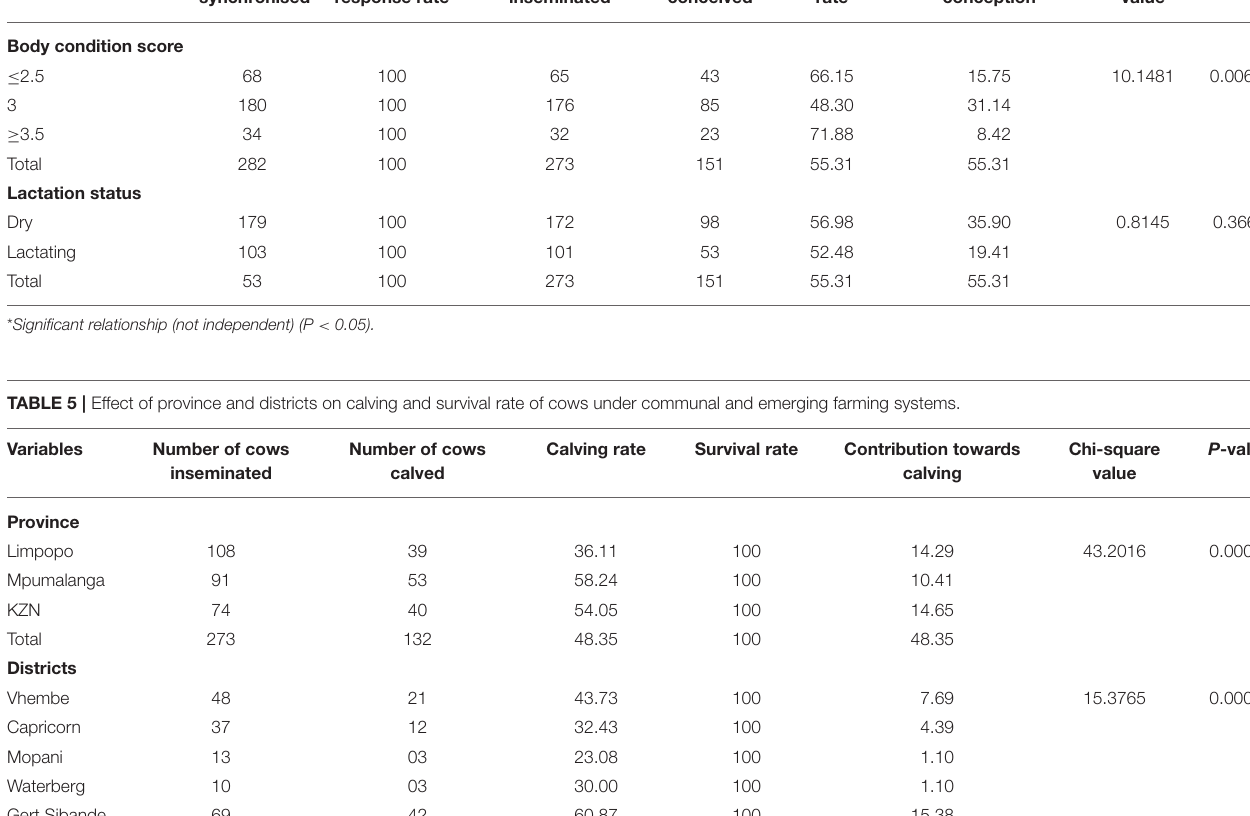
TABLE 4 | Effect of body condition score and lactation status on synchronisation response and conception rate of cows under communal and emerging farming systems. Variables